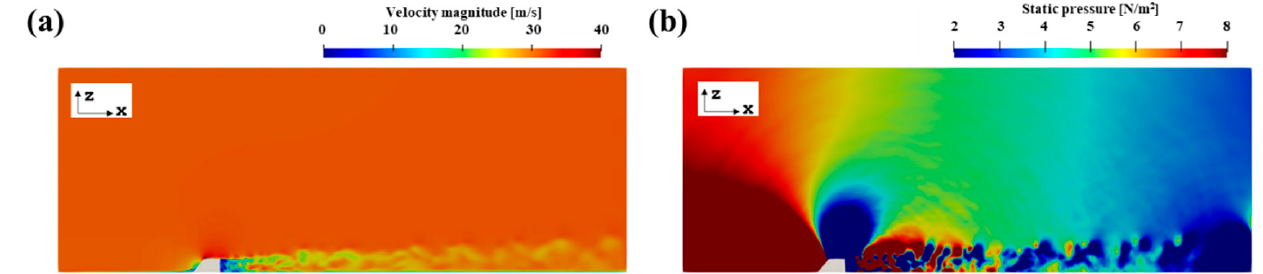
Figure 6. Snapshot of iso-contours of ( a ) velocity magnitude and ( b ) static pressure (at y = 0 m, t = 2.8 s).